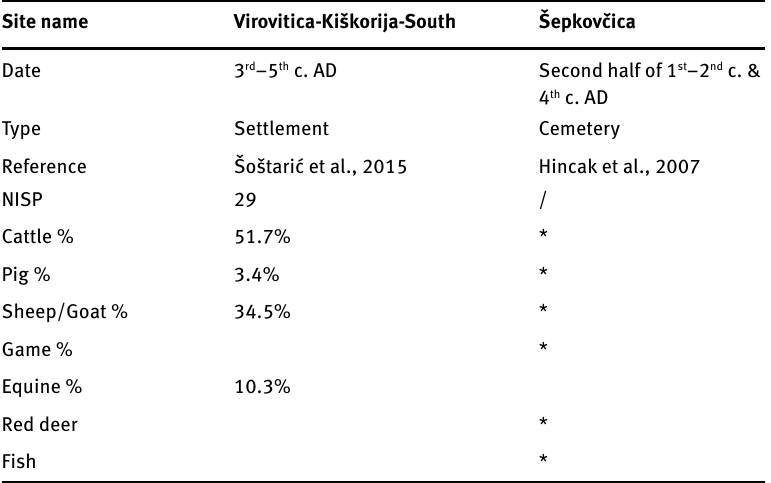
Table 3: Zooarchaeological evidence from Southern Pannonia, Croatia. * = presence